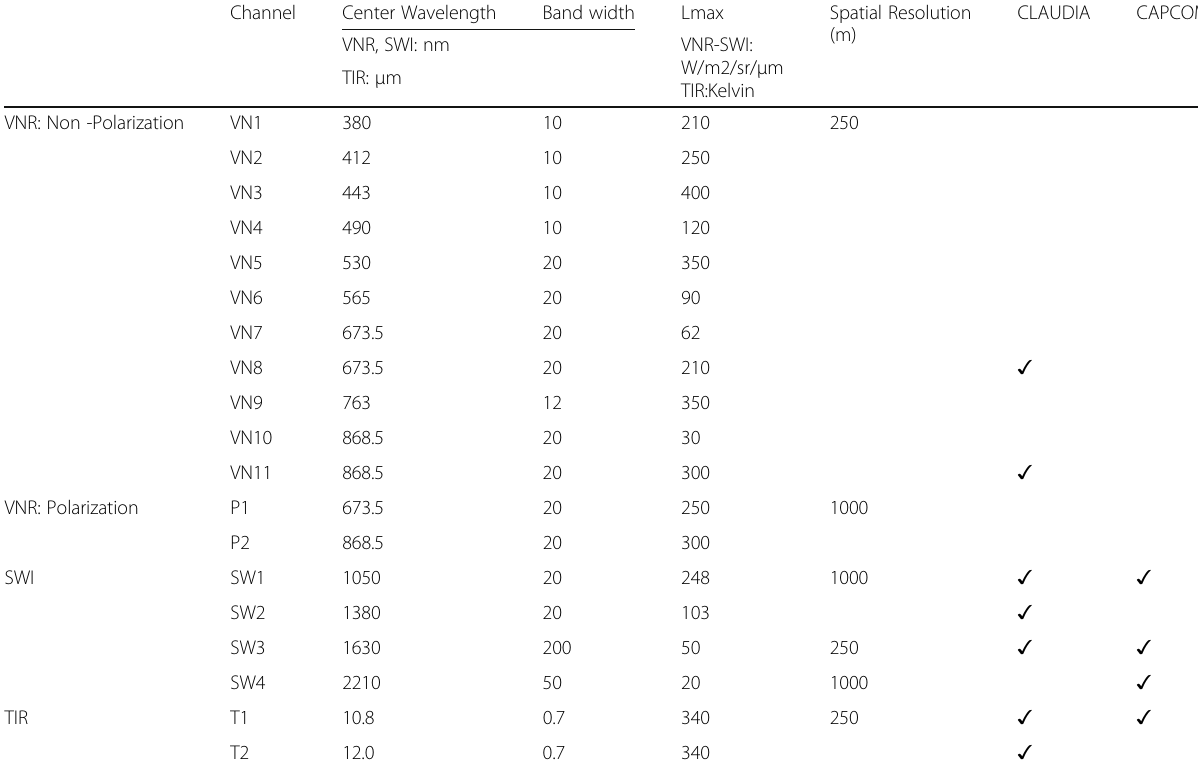
Table 1 GCOM-C SGLI channel specifications and channel use by CLAUDIA and CAPCOM. Lmax denotes maximum observed radiance for each